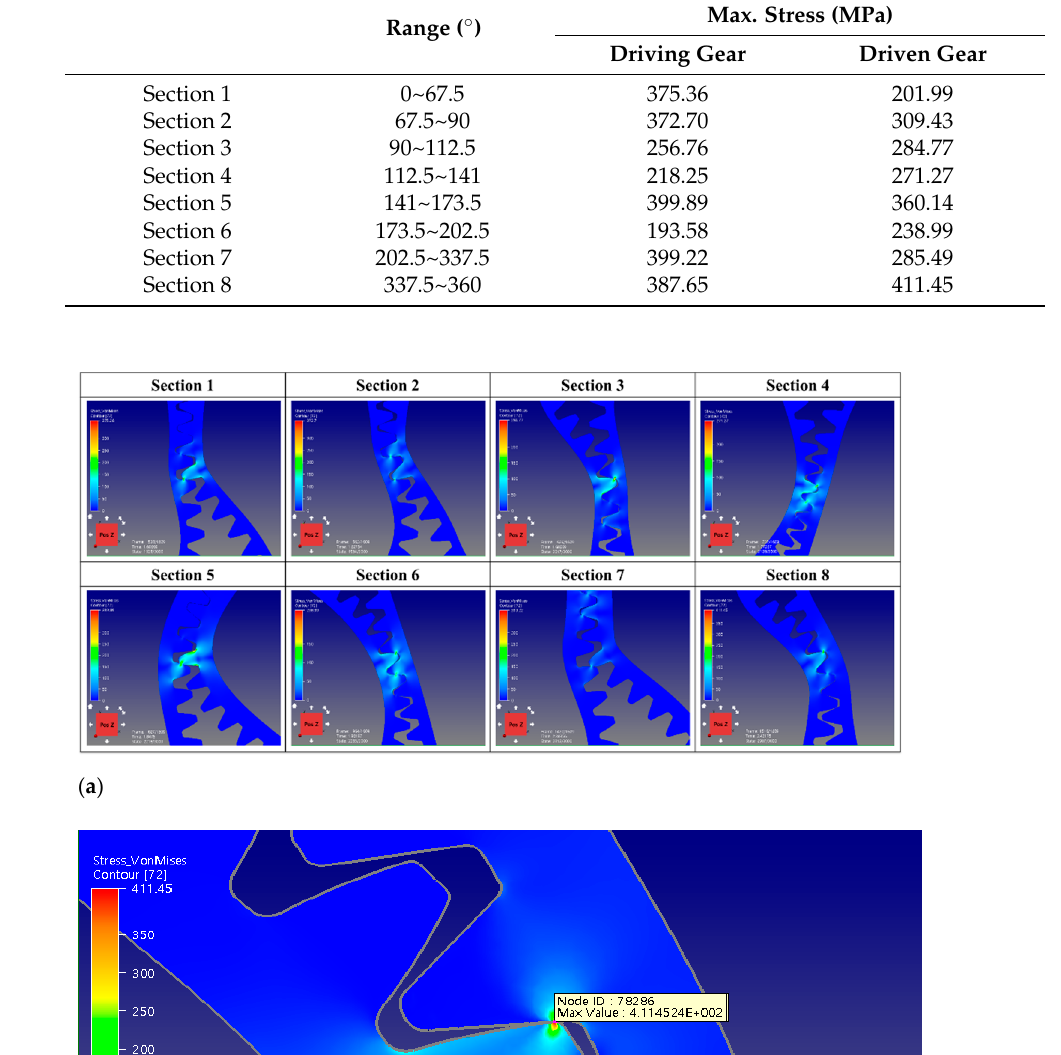
Table 4. Max. equivalent stress result for each section.